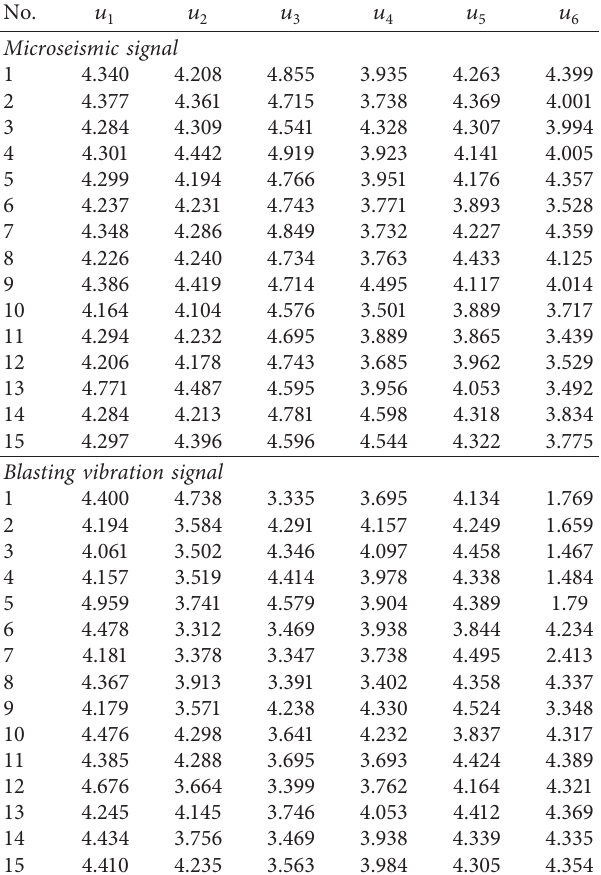
Table 2: Singular spectrum entropy of each mode of the rock fracture microseismic and blasting vibration signals.